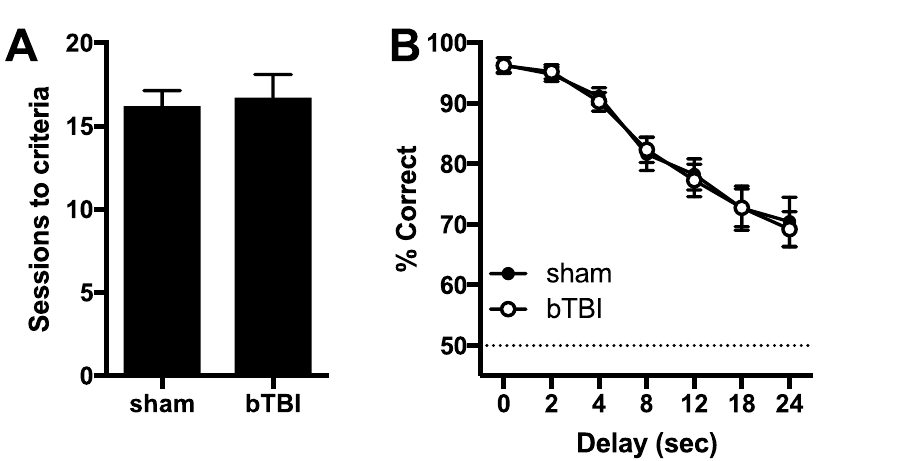
Figure 5. Acquisition and performance of the delayed matching to sample task. ( A ) Number of sessions required to meet criteria from the beginning of the task until completion of delay set 2. ( B ) Percentage of correct responses across delay periods. Symbols represent mean ± SEM. N =